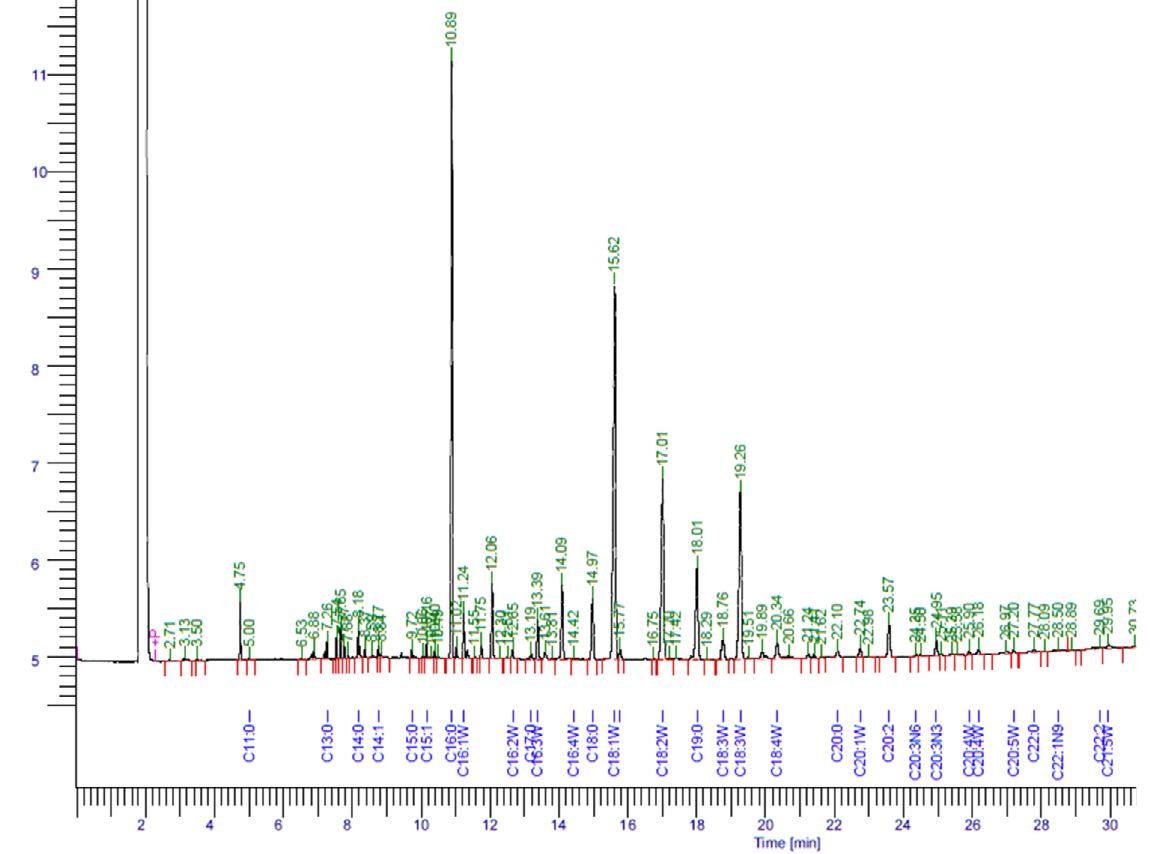
Figure 10. Chromatogram of fatty acid profile from “La Orden” microalga oil. Table 7. Initial characterization of substrates used in the anaerobic digestion